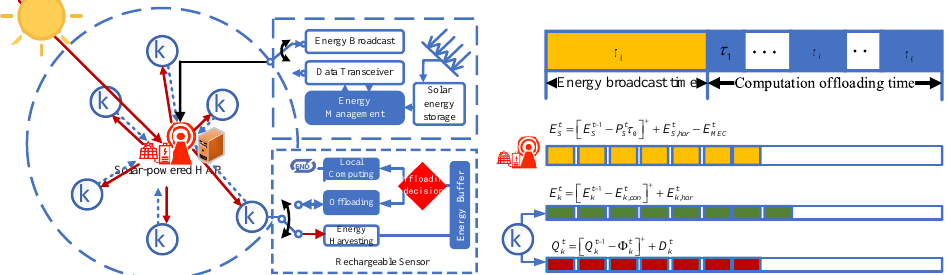
Figure 1. The overview of solar-powered WSN based on hybrid multi-access. The SC consistently harvests and stores solar energy for charging a set of battery-free sensor nodes. The node does local computing and remote offloading based on the harvested energy.